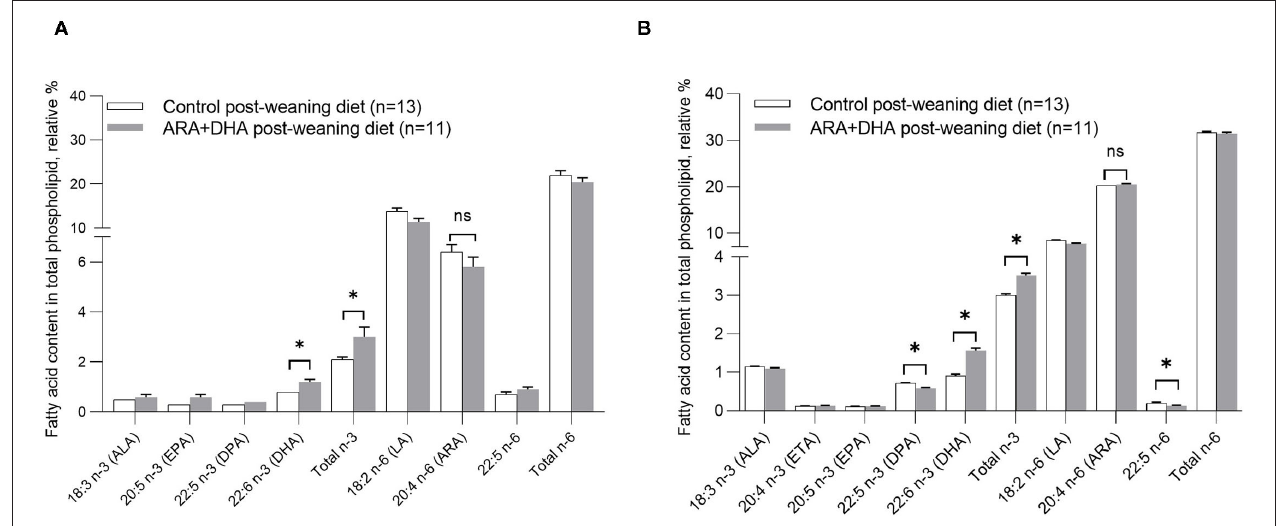
FIGURE 2 | Effect of post-weaning diet on the relative % of fatty acid content in total phospholipids in (A) plasma and (B) splenocytes of 8-week-old Brown Norway offspring. All values are presented in mean ± SE. At 8 weeks, there was no significant effect of the suckling period diet (0–3 weeks) or the suckling diet × post-weaning diet interaction. Therefore, the suckling diet groups were combined, and the differences observed by significant post-weaning diet were calculated by unpaired Student t- test. * p < 0.05. ALA, α -linolenic acid; DPA, docosapentaenoic acid; EPA, eicosapentaenoic acid; DPA, docosapentaenoic acid; DHA, docosahexaenoic acid; LA, linoleic acid; ARA, arachidonic acid.